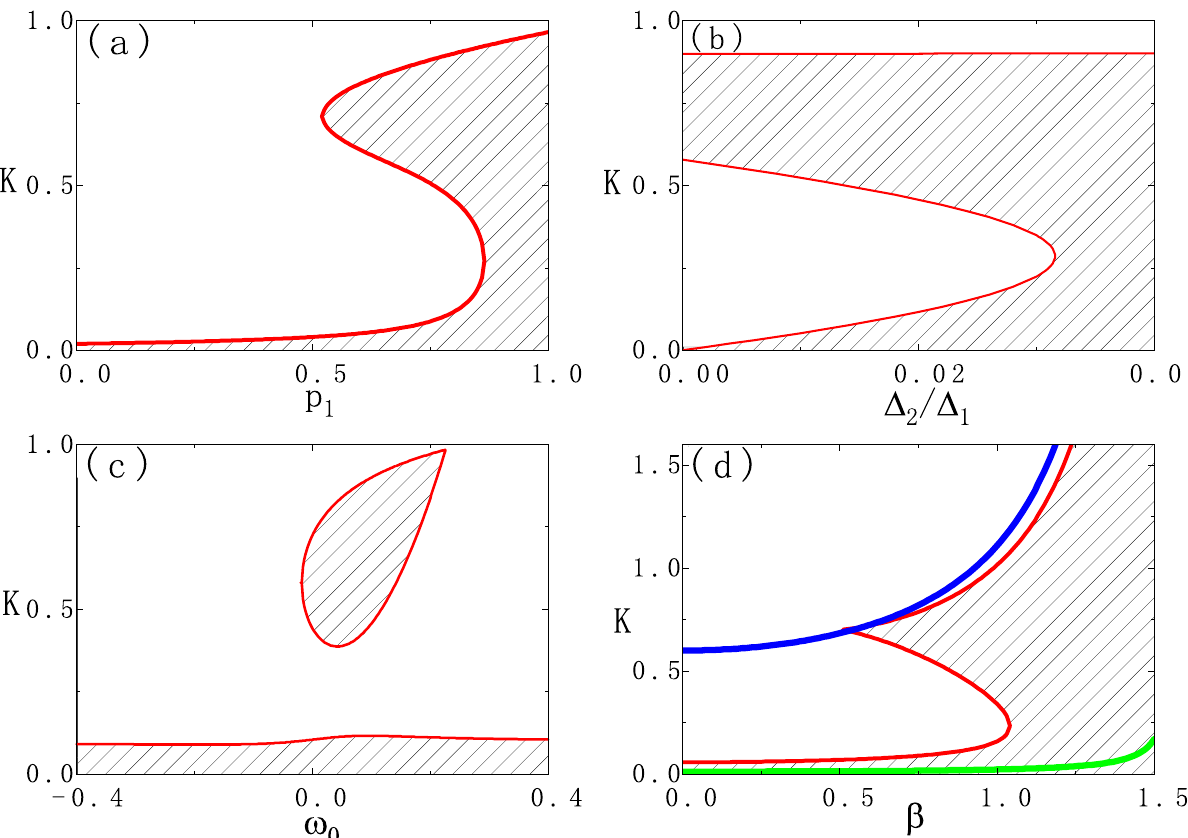
Fig 5. (Color online) Stability diagrams of the incoherent state for asymmetrical bimodal frequency distribution on various parameter planes. (a) ( K , p 1 ) plane at β = 0.9, Δ 1 = 0.3, Δ 2 / Δ 1 = 0.02, and ω 0 = 0.1; (b) ( K , Δ 2 / Δ 1 ) plane at β = 0.9, Δ 1 = 0.3, ω 0 = 0.1, and p 1 = 0.8; (c) ( K , ω 0 ) plane at β = 0.9, Δ 1 = 0.3, Δ 2 / Δ 1 = 0.02, and p 1 = 0.8; (d) ( K , β ) plane at Δ 1 = 0.3, Δ 2 / Δ 1 = 0.02, ω 0 = 0.1, and p 1 = 0.8. The shaded regions with red boundary lines, obtained from Eq (15), mark the stable incoherent state. The blue and green lines in (d) are critical curves K = 2 Δ 1 /cos β for p 1 = 1 and K = 2 Δ 2 /cos β for p 1 = 0,